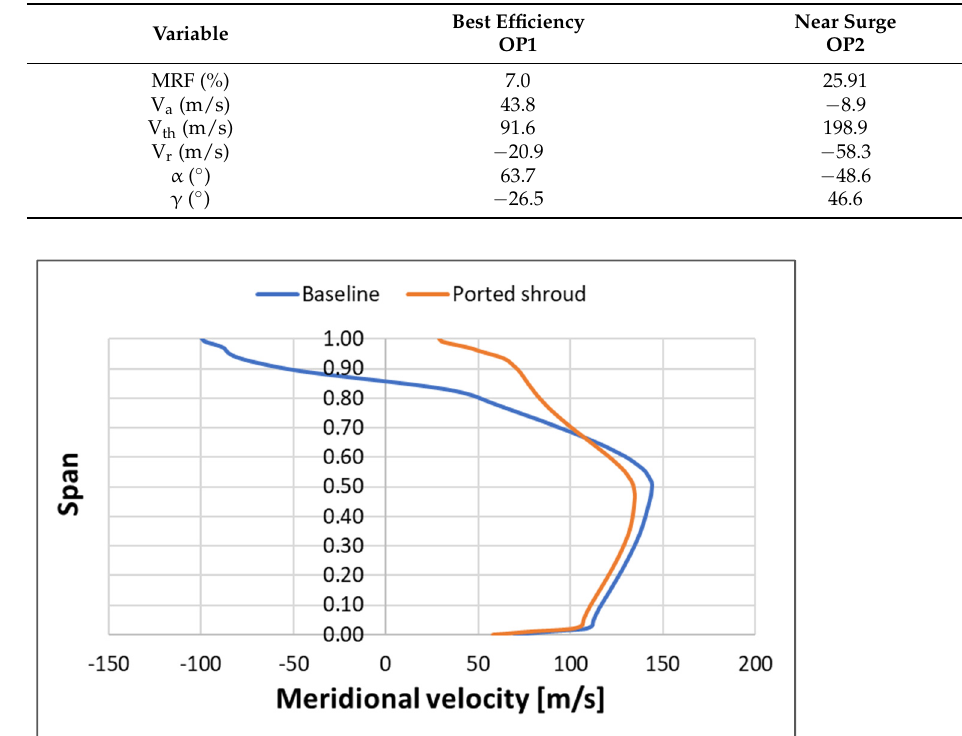
Figure 12. Comparison of the hub-to-shroud distribution of the meridional velocity at the leading edge between the configurations with ported shroud and baseline, at near surge condition OP2.